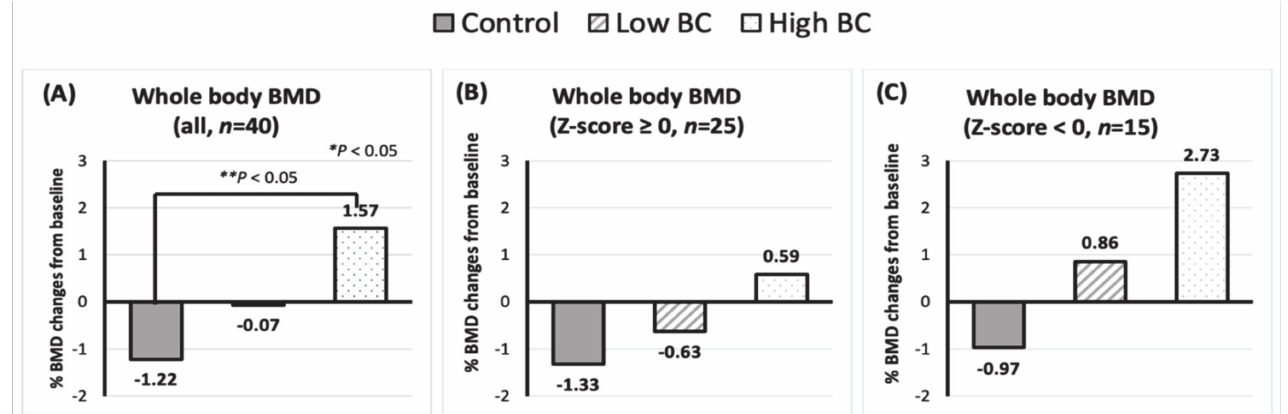
Figure 2. Changes (%) in bone mineral density (BMD) of whole body from baseline to 6 months of consumption of placebo (Control), 392 mg (low BC) and 784 mg (high BC) of blackcurrant powder for ( A ) all participants, ( B ) participants with z-scores ≥ 0, and ( C ) participants with z-score < 0. Bars represent mean. * Significance was assessed using one-way ANOVA. ** Significance was assessed by t -test for control and low BC and control and high BC groups,